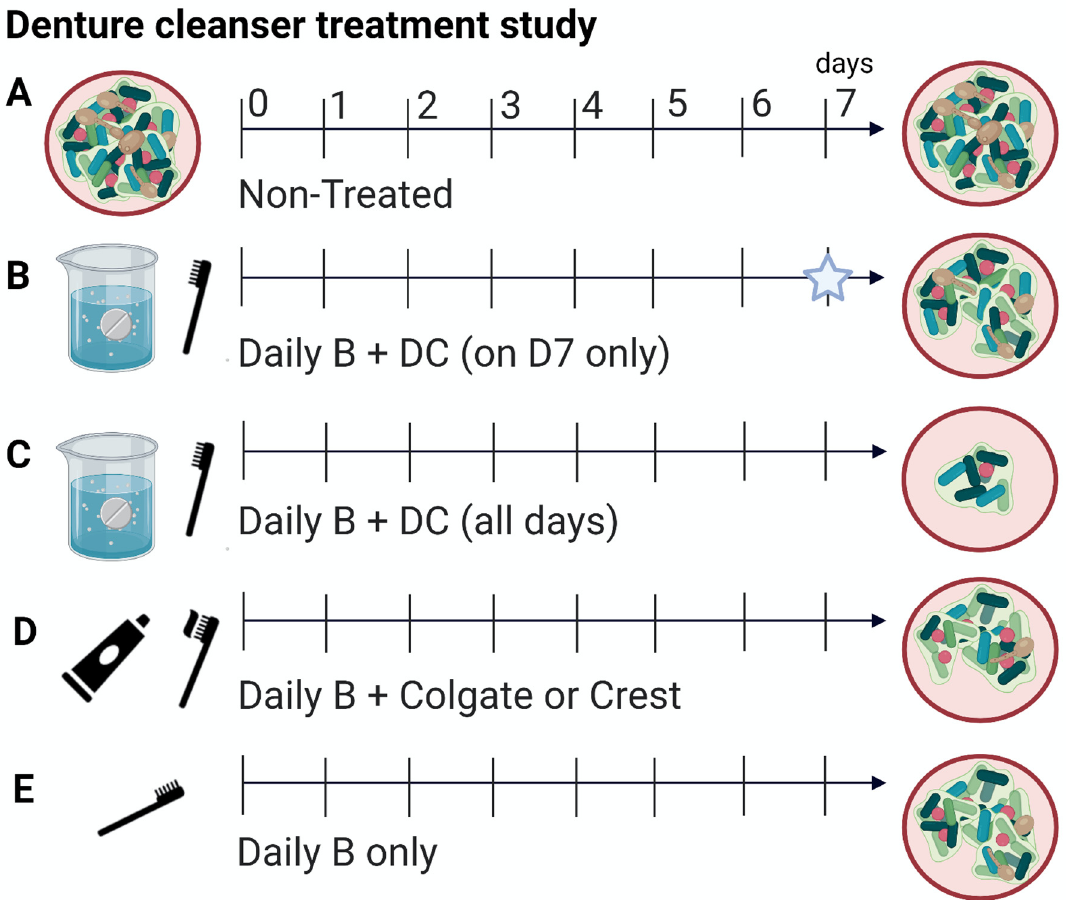
Figure 3. Schematic diagram depicting the treatment modalities used in this study. Polymicrobial biofilms were treated for 7 days with a variety of modalities. Biofilms were either left non-treated, ( A ) treated with daily brushing and denture cleanser (DC) on day 7 only (star represents single treatment), ( B ) daily brushing and DC on all days, ( C ) daily brushing with Colgate ® toothpaste or Crest ® toothpaste, ( D ) and finally, brushing only minus additional treatment, ( E ). Figure was created using Biorender.com (accessed on 1 November 2021).